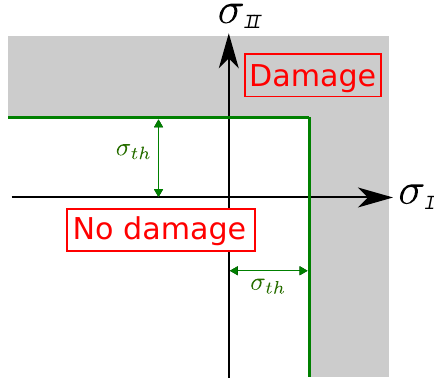
Figure 1. Damage envelope in the space of principal stresses. σ I and σ II represent the first and the second principal stress, respectively, while σ th is the stress threshold. The shaded area corresponds to stress conditions in the calving model that will trigger